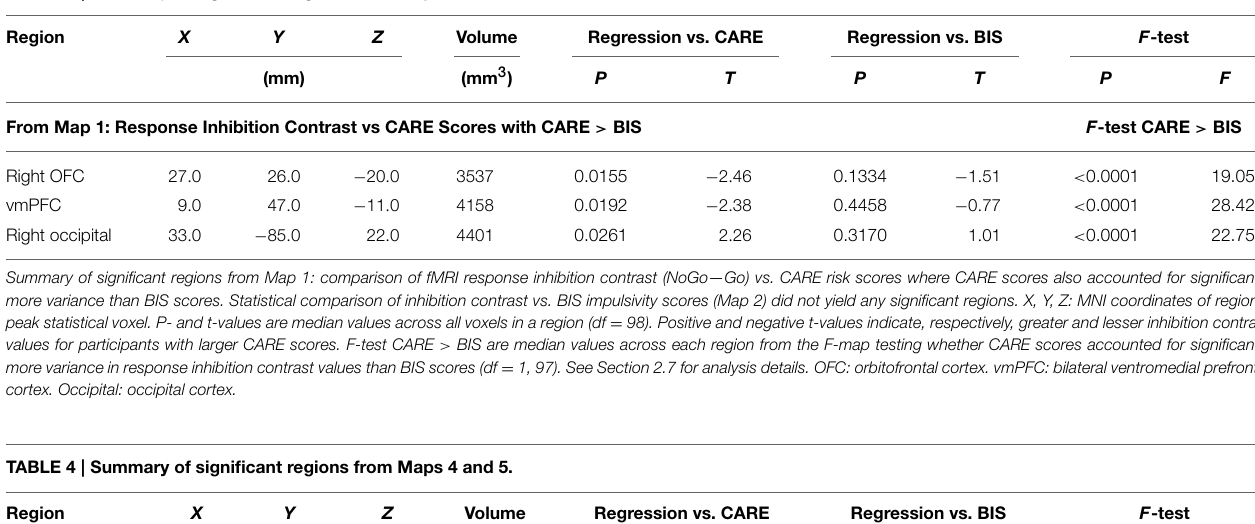
TABLE 4 | Summary of significant regions from Maps 4 and 5. Region Y Z Volume Regression vs. CARE Regression vs. BIS F -test From Map 4: Emotional Valence Contrast vs CARE Scores with CARE > BIS F -test CARE > BIS Right occipital